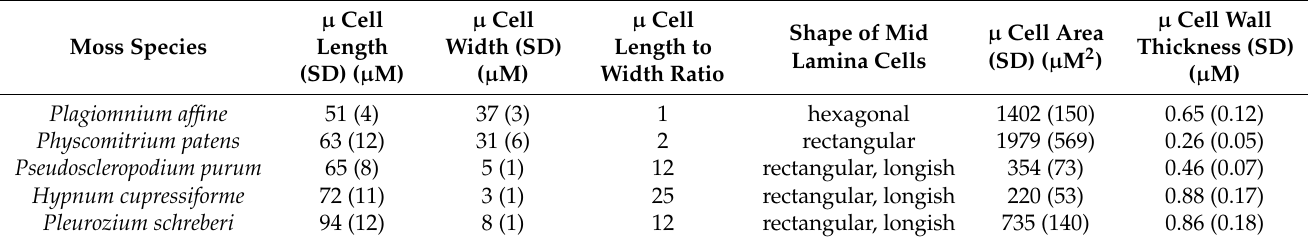
Table 1. Five moss species ( Plagiomnium affine , Physcomitrium patens , Pseudoscleropodium purum , Hypnum cupressiforme , and Pleurozium schreberi ) were compared by mean cell length ( µ m), cell width ( µ m), length to width ratio, shape, and mean cell area ( µ M 2 ) of mid lamina cells ( n = 40). SD = Standard deviation; µ = mean value; p = 0.0001 (Kruskal–Wallis test comparing all five